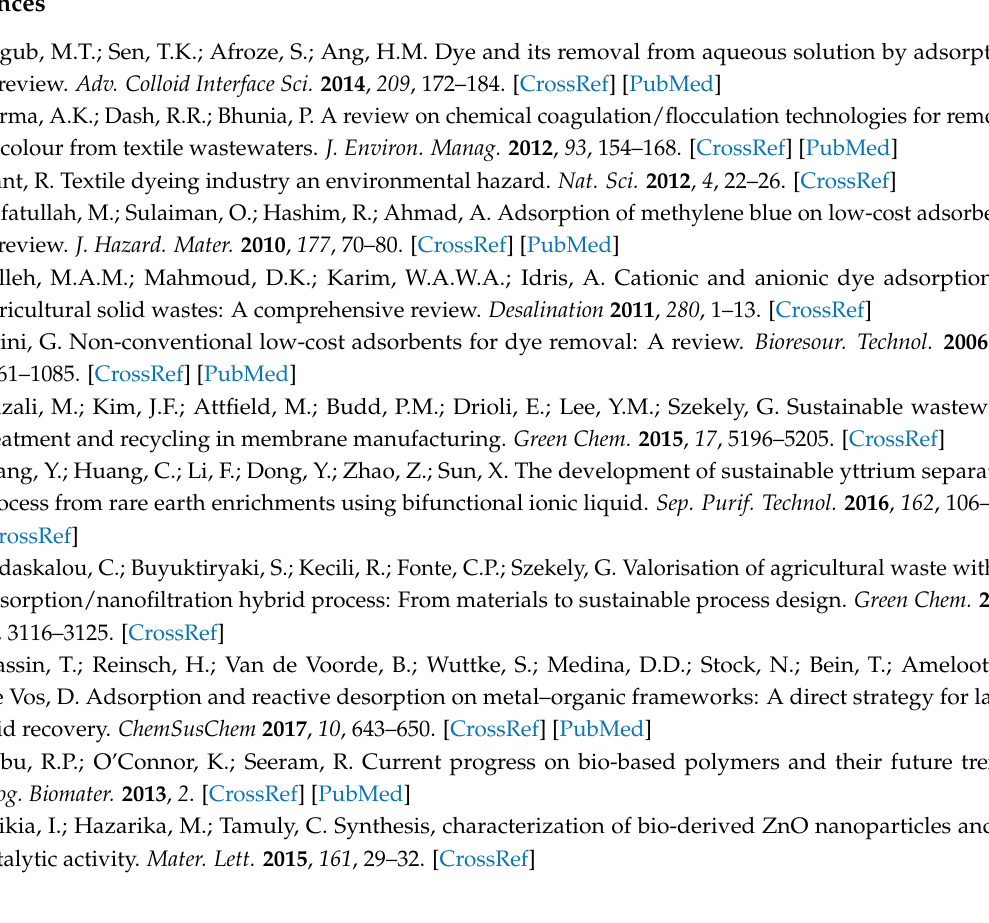
Table S1: Parameter values of the kinetics models fitting to the experimental results for adsorption, Table S2: Langmuir, Freundlich and Temkin adsorption isotherm constant, correlation coefficient and q m